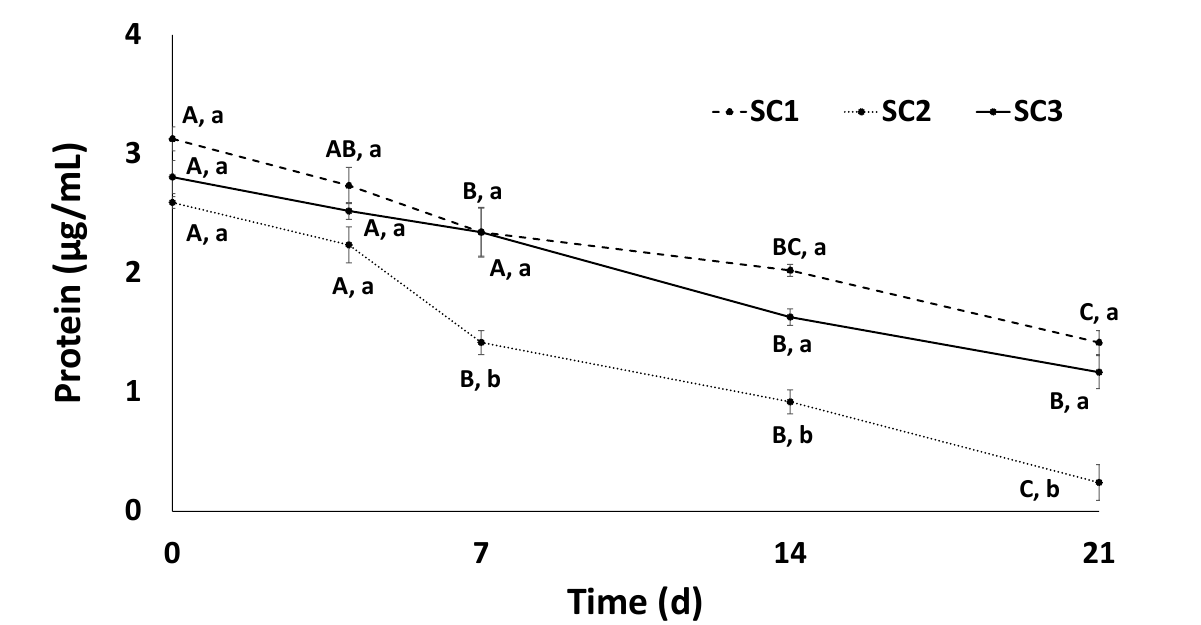
Figure 4. Evolution of total soluble protein content ( µ g/mL) in ST kombuchas fermented using SCOBYs 1, 2, and 3 (SC1, SC2, SC3). Different letters show statistical significance ( p ≤ 0.05) between different fermentation days for the same SCOBY (A–C) and between different SCOBYs for the same fermentation day (a,b).